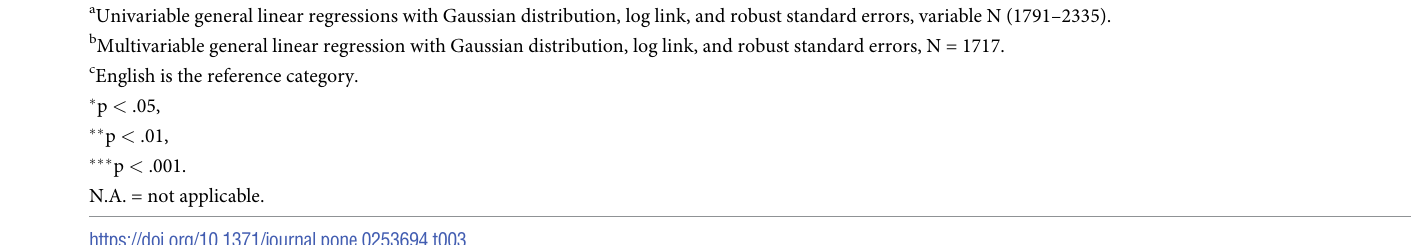
a Univariable general linear regressions with Gaussian distribution, log link, and robust standard errors, variable N (1791–2335). b Multivariable general linear regression with Gaussian distribution, log link, and robust standard errors, N = 1717. c English is the reference category.